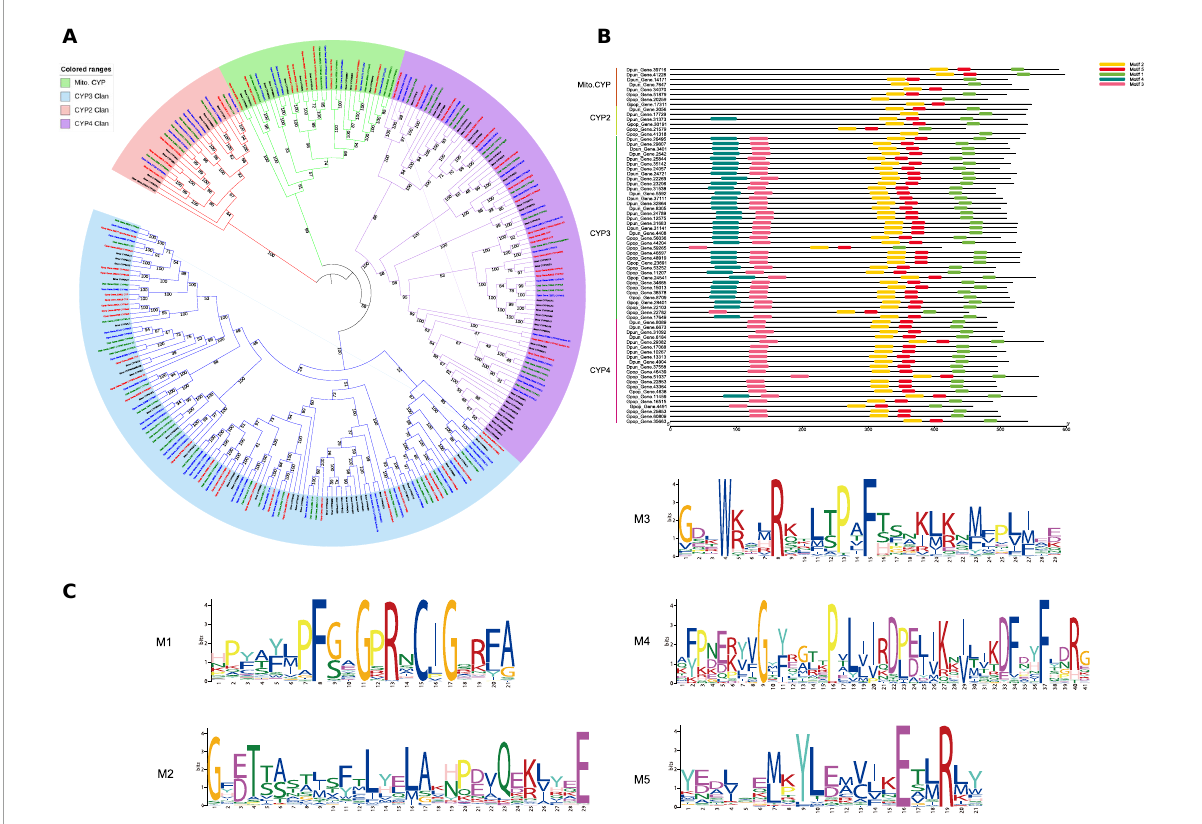
FIGURE1 (A) Maximum-likelihood phylogram of cytochrome P450. Sequences from Dendrolimus punctatus (blue), Gastropacha populifolia (red), Dendrolimus tabulaeformis (green), and the genome data of Bombyx mori (Violet ) . Highlighted clades: Mito.CYP clan is marked in green, CYP2 clan is marked in red, CYP3 clan is marked in blue, and CYP4 clan is marked in purple. (B) Predicted motif of completed P450 sequence of D. punctatus , G. populifolia , and D. tabulaeformis . Five motifs were predicted for CYP3 clan, four motifs were predicted for CYP4 clan, and two motifs were predicted for Mito.CYP and CYP2 clan. (C) The sequence logos of four consensus domains of CYP clan, the larger the letter, the more conservative the amino acid site